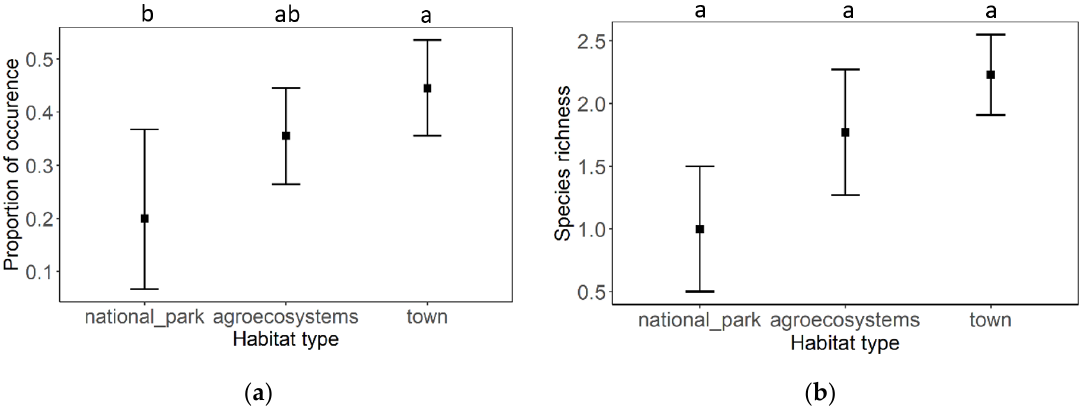
Figure 1. ( a ) The proportion of eukaryotic pathogen occurrence in different types of habitats and ( b ) the proportion of eukaryotic pathogen richness in different types of habitats. Black squares represent means and the error bars represent 95% confidence intervals. Significant differences (<0.05) are indicated by different letters. Table 2. The results of the analysis of deviance (likelihood-ratio test) testing the partial effect